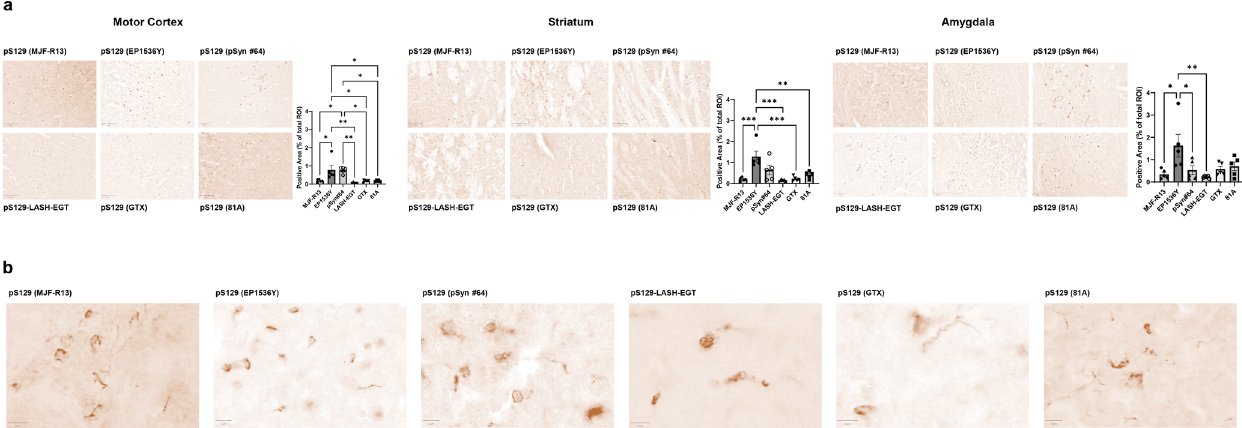
Fig. 8 Evaluation of staining pattern of aSyn pathological aggregates in WT PFF-injected mice. a Brain coronal sections (50 μ M thick) from different brain areas of C57BL6/J PFF-injected mice (Amygdala, Striatum, Motor Cortex), 3 months post-injection, have been examined to assess the different staining patterns of the six pS129 antibodies (pSyn#64, MJF-R13, 81A, EP1536Y, GTX, and LASH-EGT). Scale bar = 100 μ M. Quanti fi cation for each area has been carried out using Qupath and was expressed as a percentage of positive area stained of total ROI. Data are presented as means ± SEM. * p < 0.05, ** p < 0.01, *** p < 0.001 according to one-way ANOVA followed by the Tukey test for multiple comparisons. b Microphotographs of the amygdala were stained with the six pS129 antibodies (pSyn#64, MJF-R13, 81A, EP1536Y, GTX and LASH-EGT) at higher magni fi cation. Scale bar = 10 μ